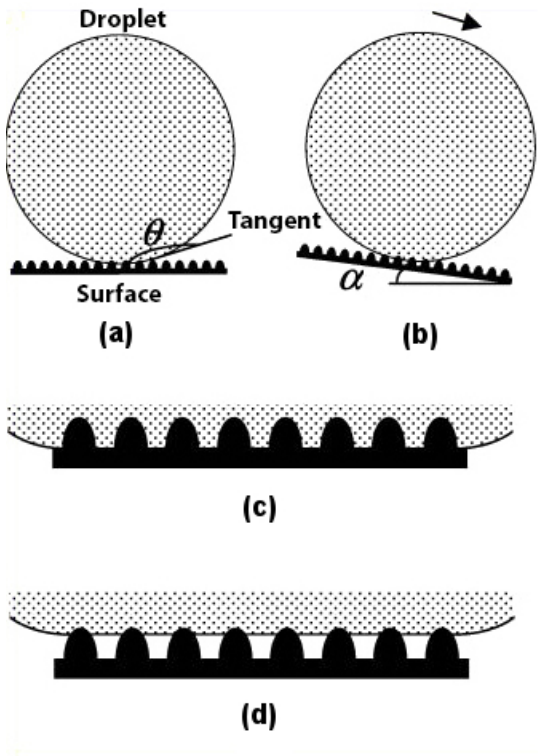
Figure 1. Water droplet on a rough surface. ( a ) Contact angle ( θ ); ( b ) Roll-off angle ( α ); ( c ) Homogeneous wetting; ( d ) Heterogeneous wetting. Adapted with permission from [17]. Copyright 2004, American Chemical